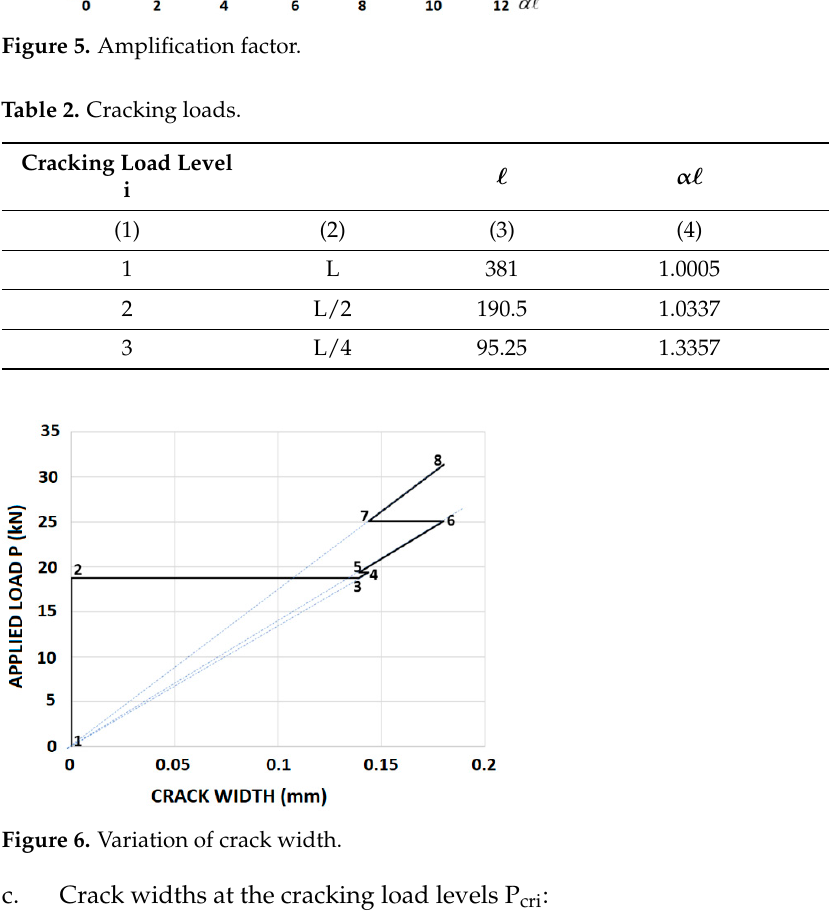
Figure 7. Total cracks width. It is interesting to note that the proposed model using the linear constitutive relation- ships and the above formulation can follow the non-monotonic behavior of crack width opening and partial closure during loading. It should be mentioned that this behavior has not been identified so far, except for a single experiment [39] mainly because it requires careful measurements, which place the sufficiently sensitive gauges mounted at the loca- tion of a crack that has not been opened yet. To overcome that difficulty, Wollrab et al. [39] prepared a notch to precisely control the crack opening location and installed gauges bridging over that location thus enabling the measurement of the crack width [31]. 3.3.4. The Force–Elongation Relationship In most of the tension-stiffening tests, the applied force and the resulting elongation at the rebar ends are measured and the force–elongation relationship is depicted. The proposed model can easily produce the force–elongation relationship. Due to the linear force–elongation relationship for a given cracking topology, it is sufficient to calcu- late the elongation at the cracking load levels, prior and after the new crack(s) opening. Following the stages shown in Table 3 and using Equation (34), the following expression may be used to calculate the elongation of a sub-element of length ℓ :